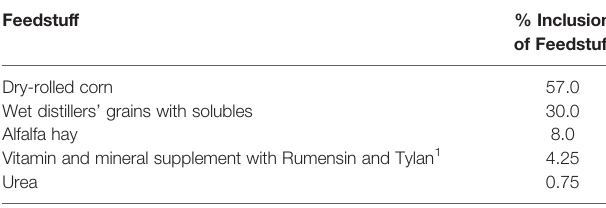
TABLE 1 | Diet on a dry-matter basis.